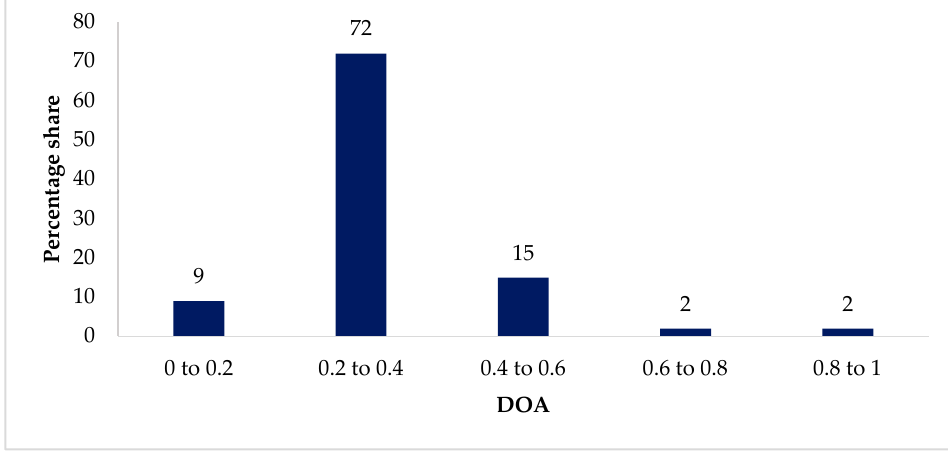
Figure 11. Percentage distribution of degree of applicability (DOA).